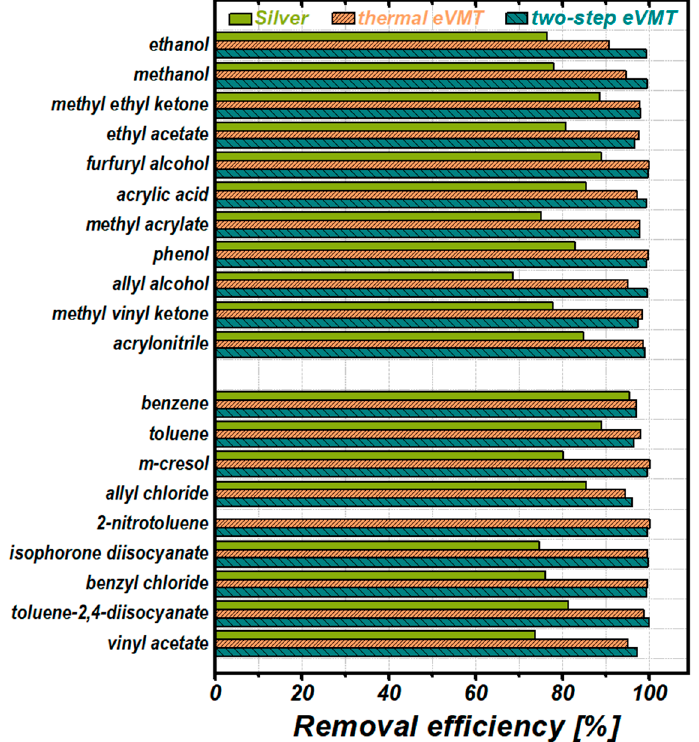
Figure 9. Horizontal bar charts displaying the removal efficiencies of three different eVMTs for various hazardous liquid chemicals.